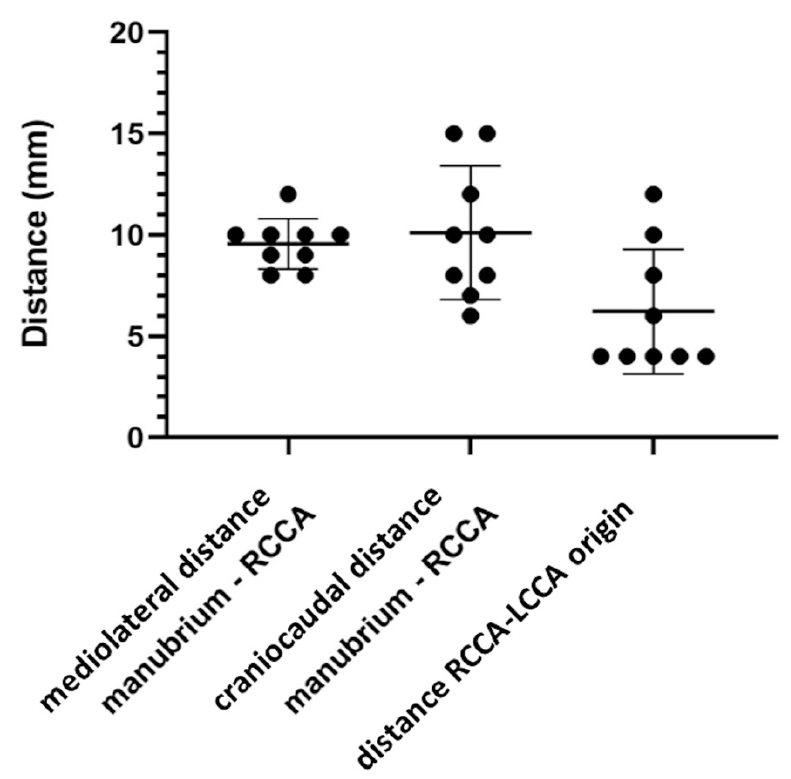
Figure 3. Measured distance between the tip of the manubrium and the origin of the right com- mon carotid artery at the brachiocephalic trunk in a mediolateral direction (SD ± 1.2 mm), in the craniocaudal direction (SD ± 3.3 mm) and distance between RCCA and LCCA origins (SD ± 3.1 mm).